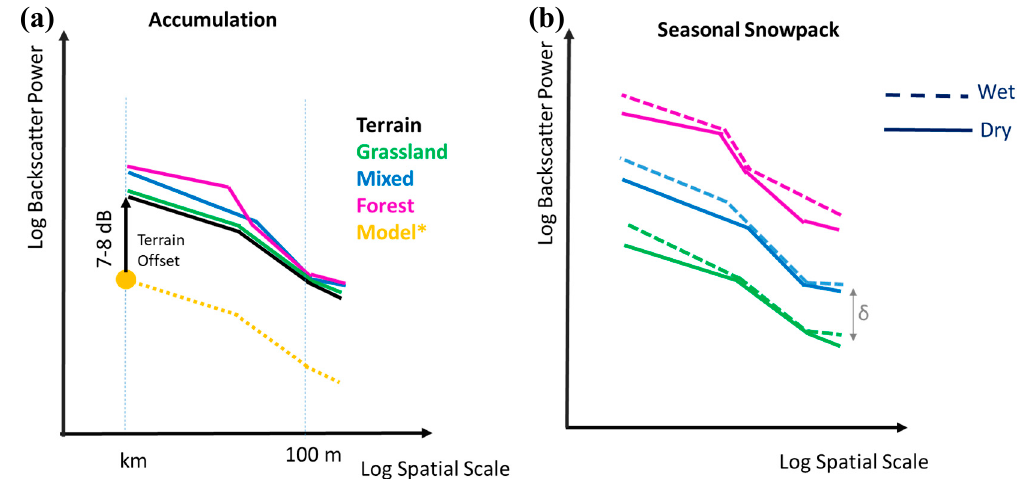
Figure 18. ( a ) Synthesis of scaling behavior of Sentinel-1 C-Band SAR backscatter in the Grand Mesa during 2017 from [9] that can be used to estimate the snowpack backscatter over different backgrounds (Green-grassland; Pink- forest; Blue-Mixed grass and forest) backscatter simulated in this study (orange circle) and at different spatial resolutions using fractal downscaling [42]. ( b ) Contrast between scaling behavior for dry and wet snow conditions. The spectra for different land- covers were separated by and arbitrary δ to facilitate visualization.